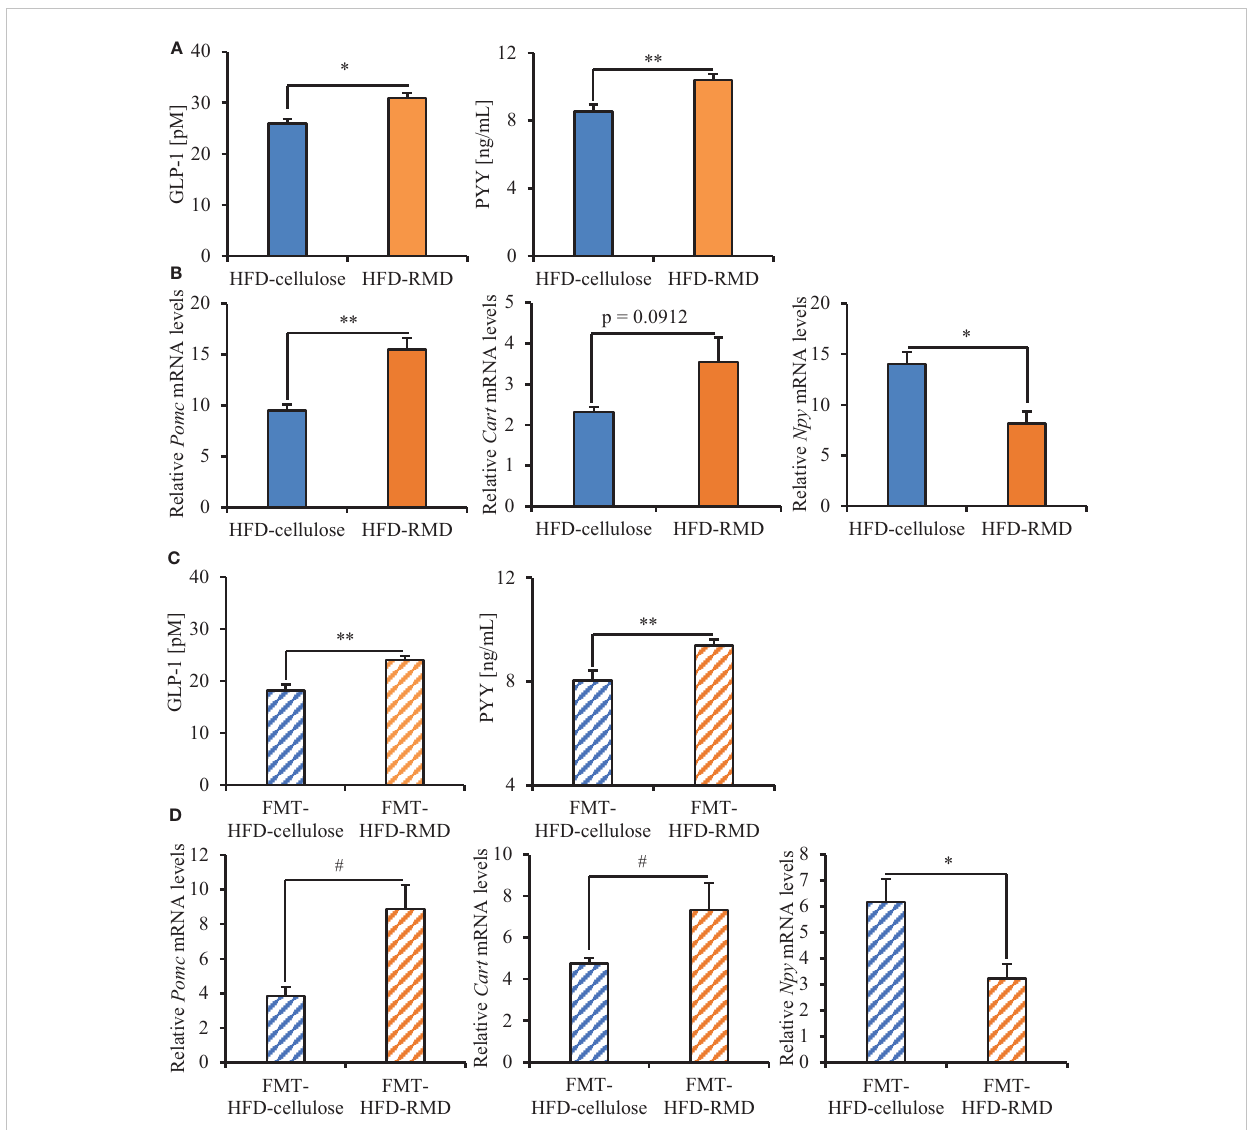
FIGURE 9 Serum levels of appetite-related gut hormones and neuropeptides mRNA in hypothalamus of the FMT-donor and recipient mice. Serum values for active GLP-1 and PYY in (A) the FMT-donor and (C) recipient mice. (B) Hypothalamic levels of Pomc , Cart , and Npy mRNA in (B) the FMT-donor and (D) recipient mice. Data are shown as means ± SEM (the FMT-donor mice, n = 4; FMT-recipient mice, n = 7). * p < 0.05, ** p < 0.01 (unpaired t-test). # p < 0.05 (Mann Whitney